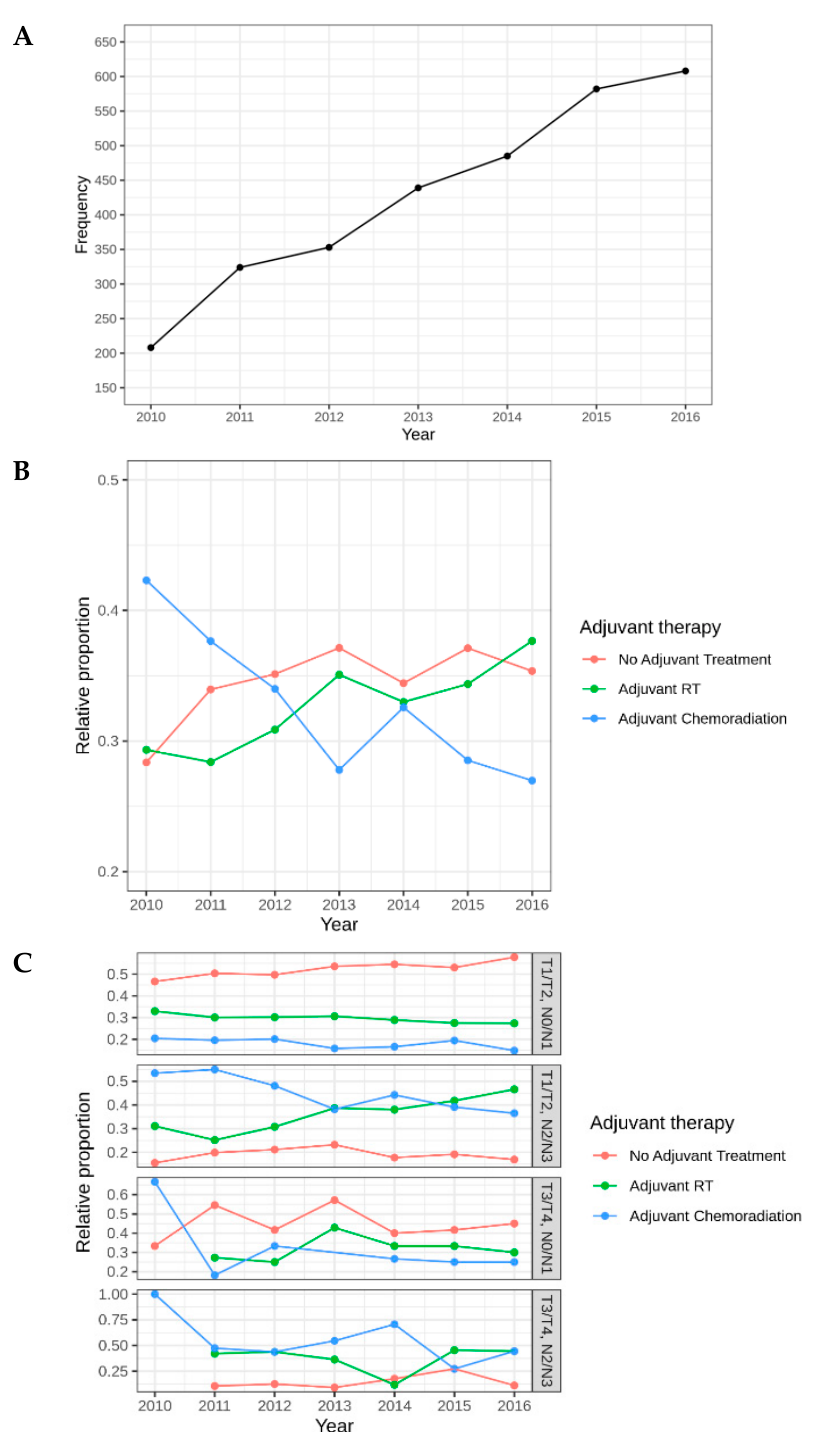
Figure 4. ( A ) Overall frequency of TORS use, ( B) relative proportion of adjuvant therapy over time, ( C ) use of adjuvant therapy by Tumor (T) and Node (N) stage.